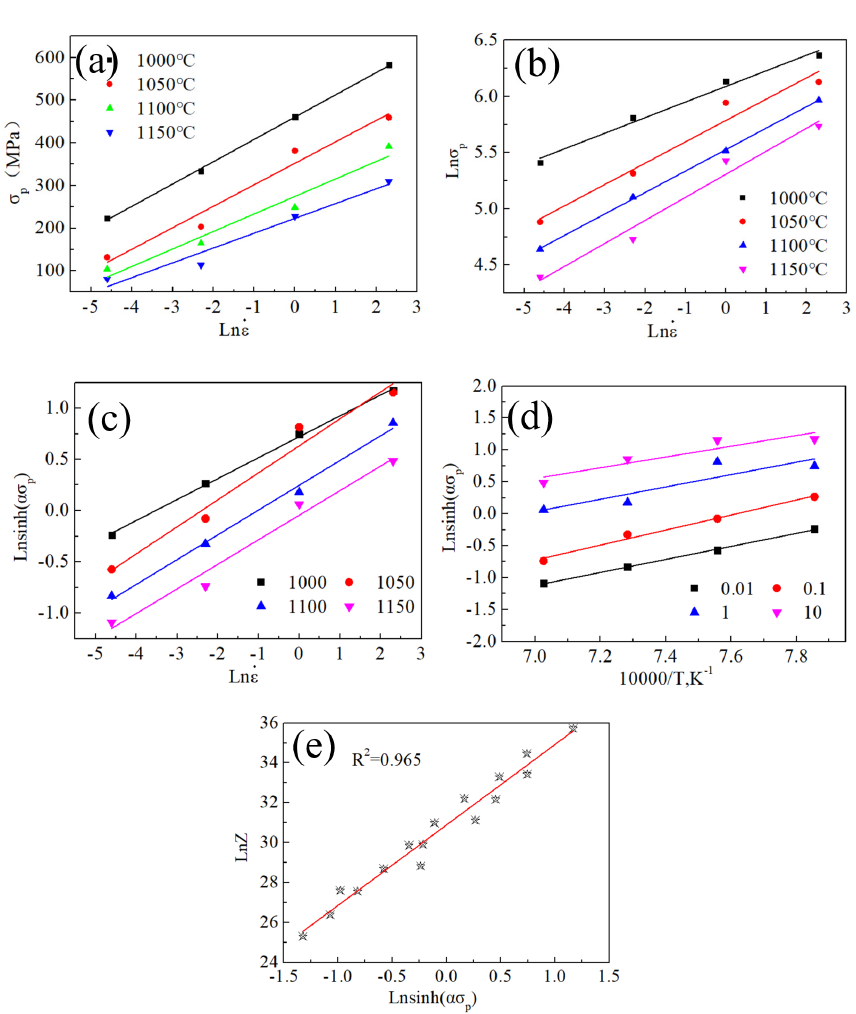
. . ε vs. σ p ; ( b ) ln ε vs. ln σ p ; ( c ) ln[sinh( α σ p )] vs. ln